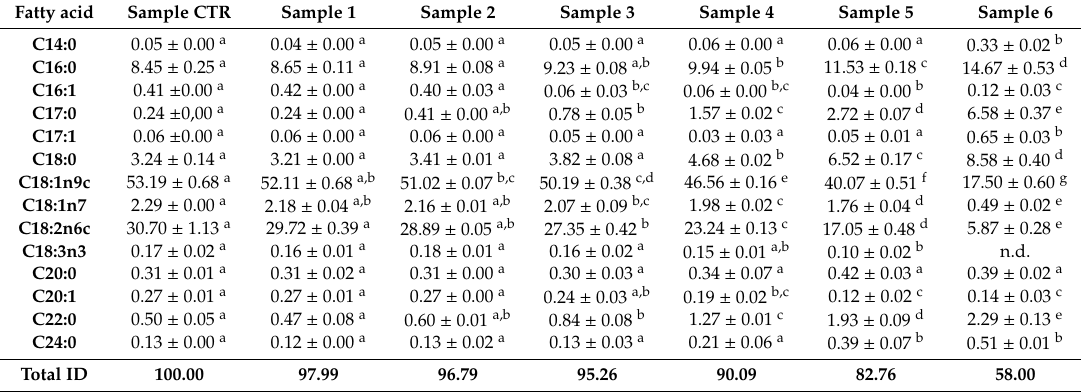
Table 2. Percentage composition of fatty acids in oils control sample (CTR) and ozonated samples. Values are presented as mean ± standard deviation ( n =